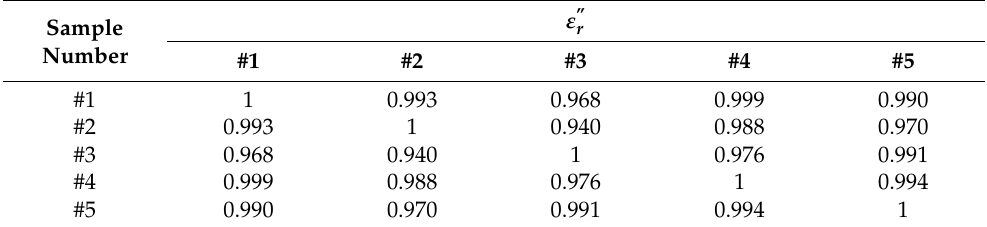
Table 4. Pearson’s coefficient for ε (cid:48)(cid:48) r measurements in the 1 MHz to 3 GHz band.